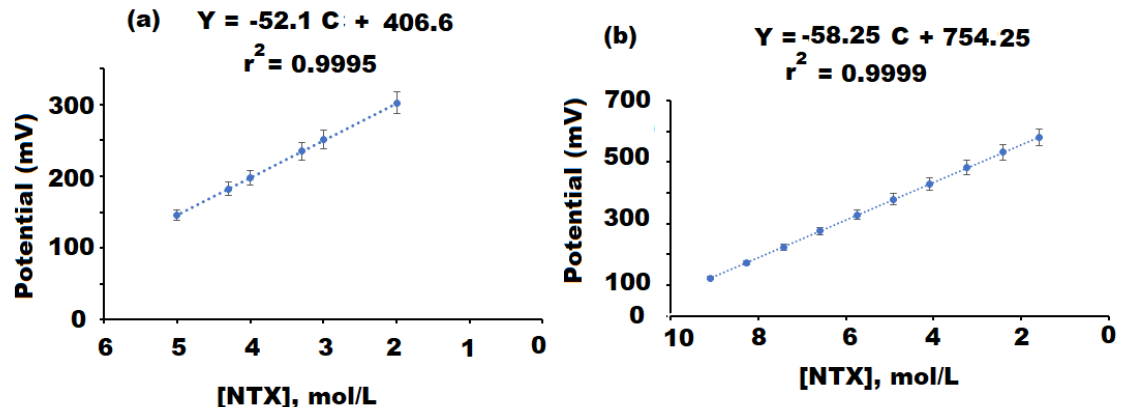
Figure 8. Linear relationships of ( a ) Conventional NTX-TPB and ( b ) NTX-TPB-CuO/Al 2 O 3 nanocomposite coated wire sensors. Table 1. Critical response features of designed conventional coated wire naltrexone -tetraphenyl borate (NTX-TPB) and modified NTX-TPB-CuO/Al 2 O 3 nanocomposite sensors.